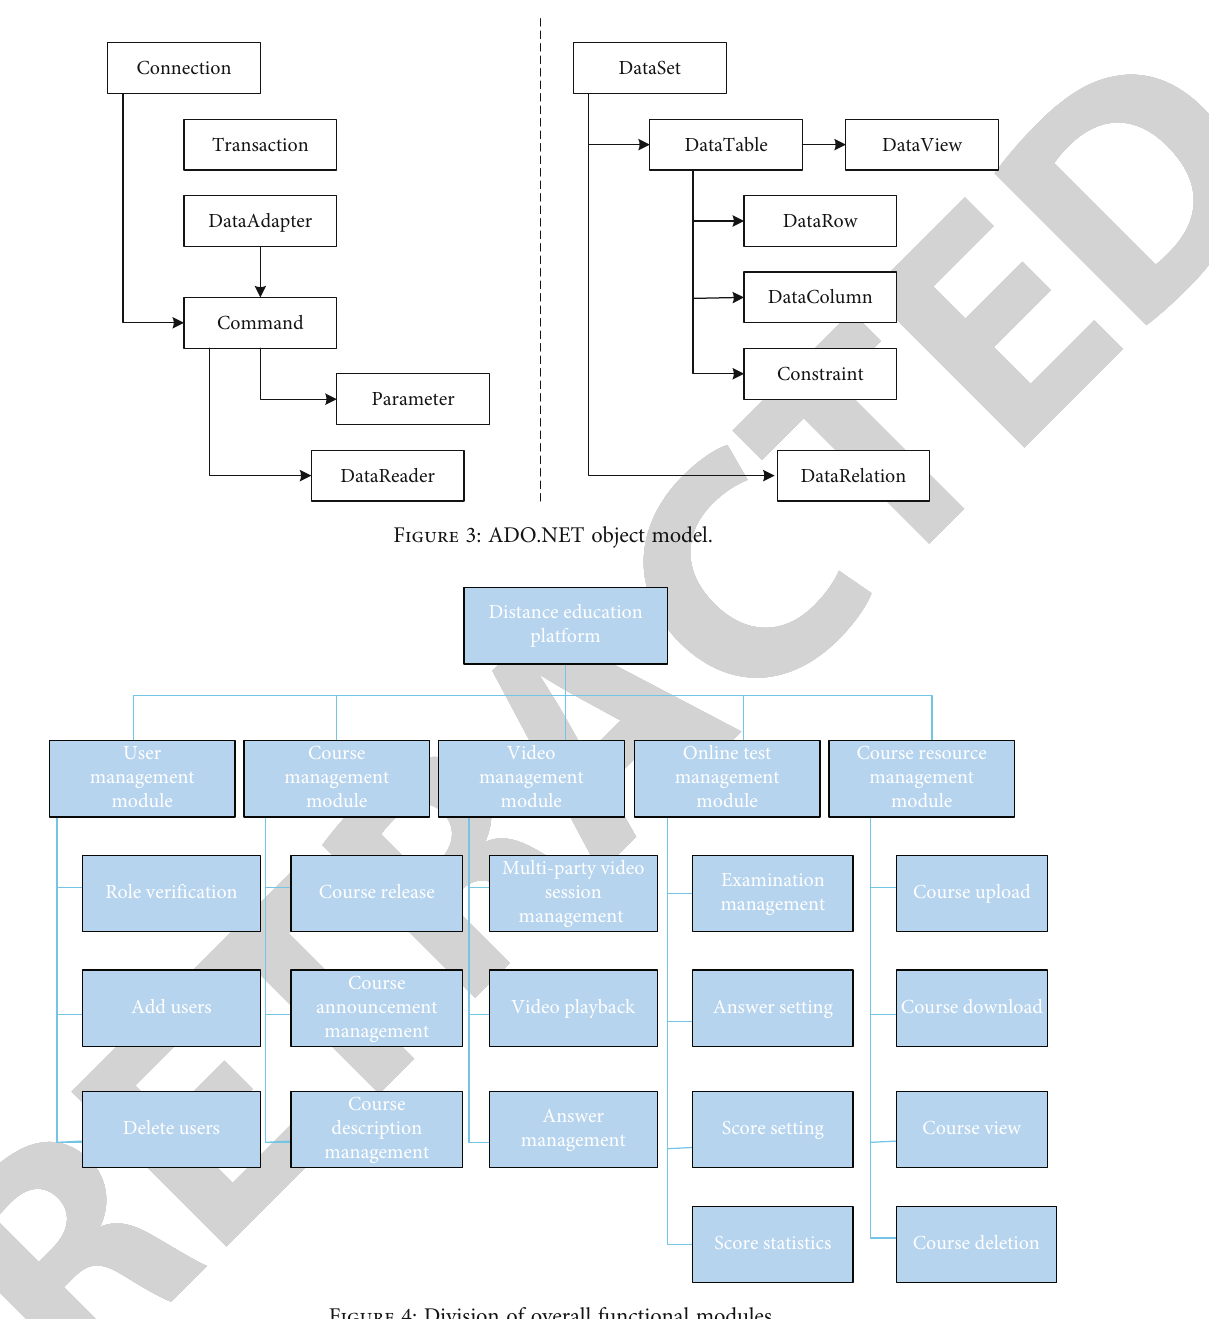
Figure 4: Division of overall functional